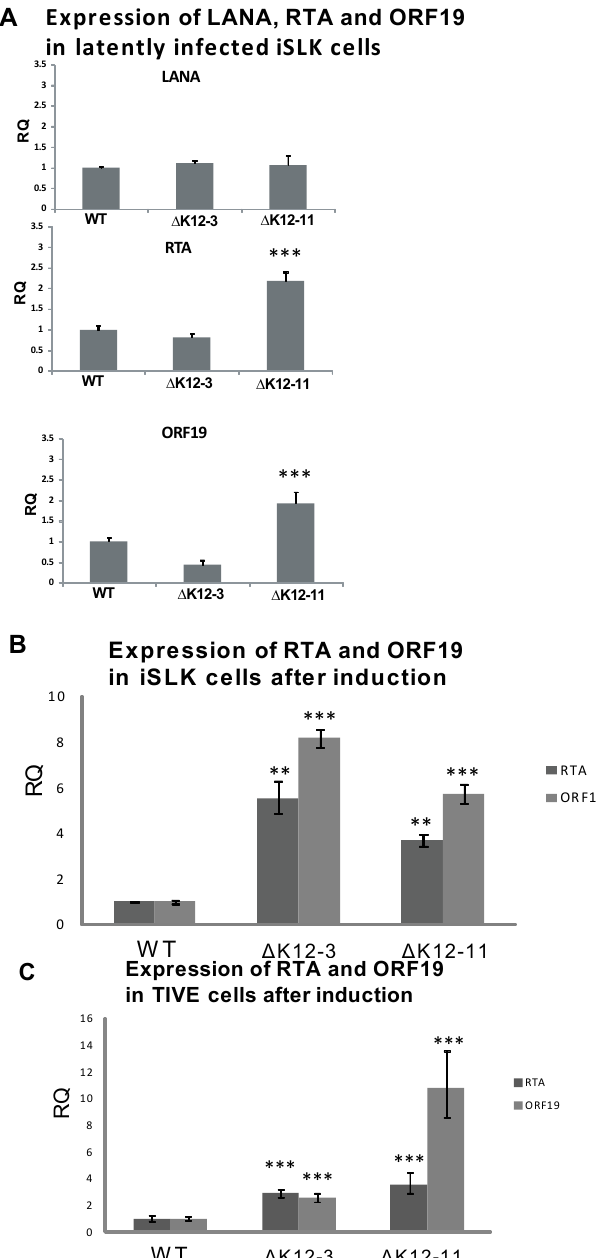
Figure 2. Expression of LANA and lytic genes in cells infected with KSHV miRNA deletion mutants. ( A ) iSLK cells latently infected with WT, ∆miR-K12-3, or ∆miR-K12-11 BAC16-derived KSHV were harvested for RNA and RT-qPCR was performed for LANA, RTA, and ORF19. All samples were normalized to β-actin expression; ( B ) Expression of RTA and ORF19 genes following induction of iSLK cells infected with WT, ∆miR-K12-3, or ∆miR-K12-11 KSHV mutants. Total RNA was harvested at 72 h post induction with 2 mM sodium butyrate and RT-qPCR performed for RTA and ORF19. All samples were normalized to β-actin and LANA expression. Samples were compared to the WT control. p < 0.05 ( * ), p < 0.01 ( ** ), p < 0.001 ( *** ); ( C ) Expression of RTA and ORF19 genes following induction of TIVE cells infected with WT, ∆miR-K12-3, or ∆miR-K12-11 KSHV